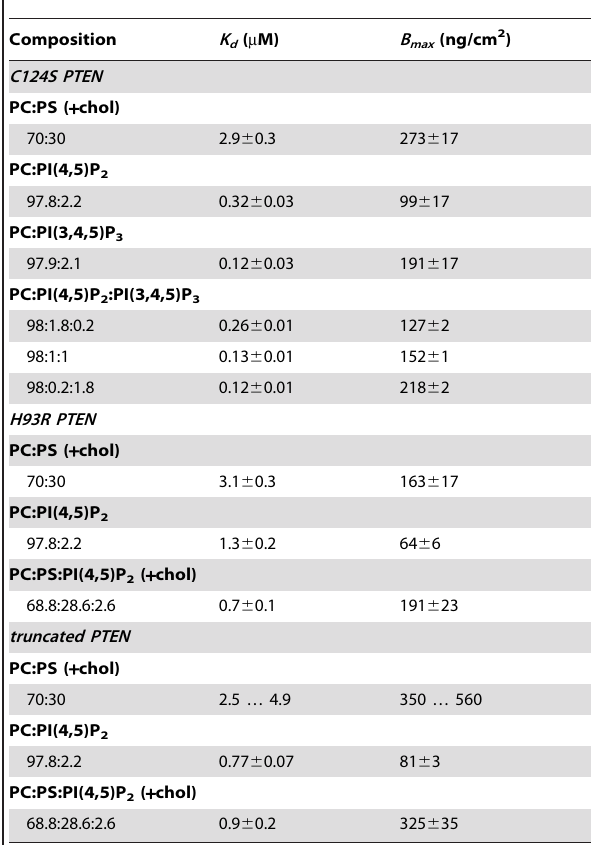
Table 2. Quantification of mutant PTEN Binding to stBLMs by